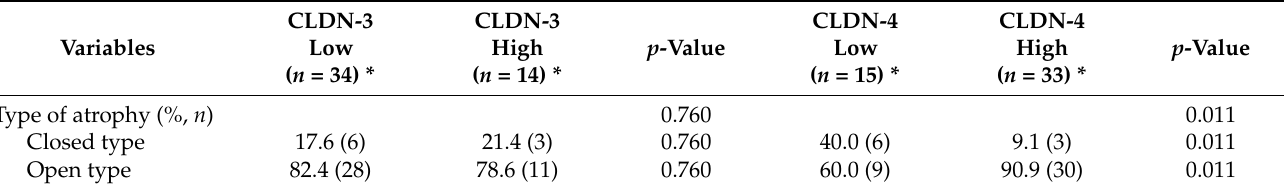
Table 3. Atrophy type according to high and low expressions of CLDN-3 and CLDN-4.